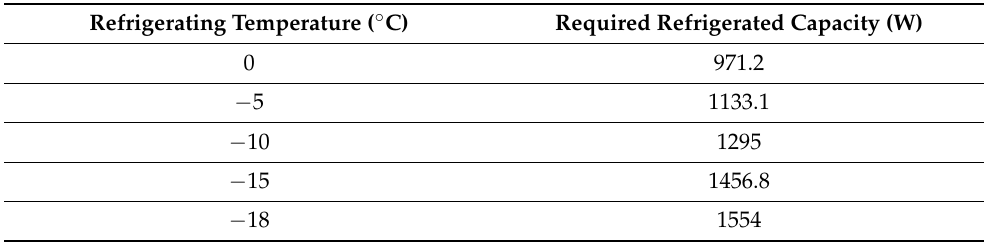
Table 7. Required refrigerating capacity under different refrigerating temperatures. Reprinted from ref. [59] with permission from